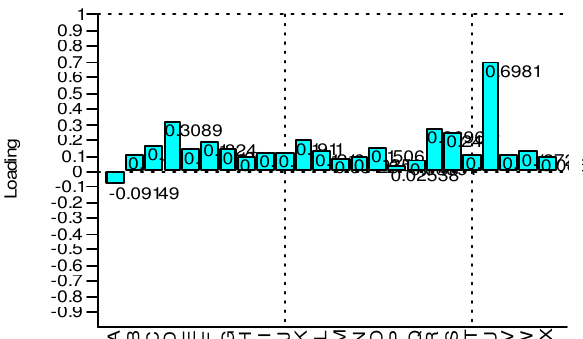
Fig. 4. Respective T. zillii morphometric characters and their loadings on PC1 of the principal components analysis showing lower jaw width as the character most responsible for variation among the studied populations of T.